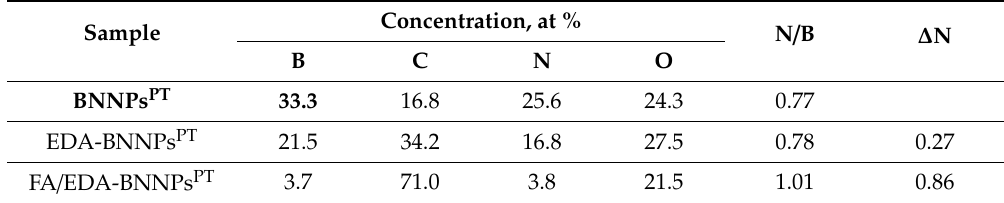
Table 2. Results of XPS analysis.